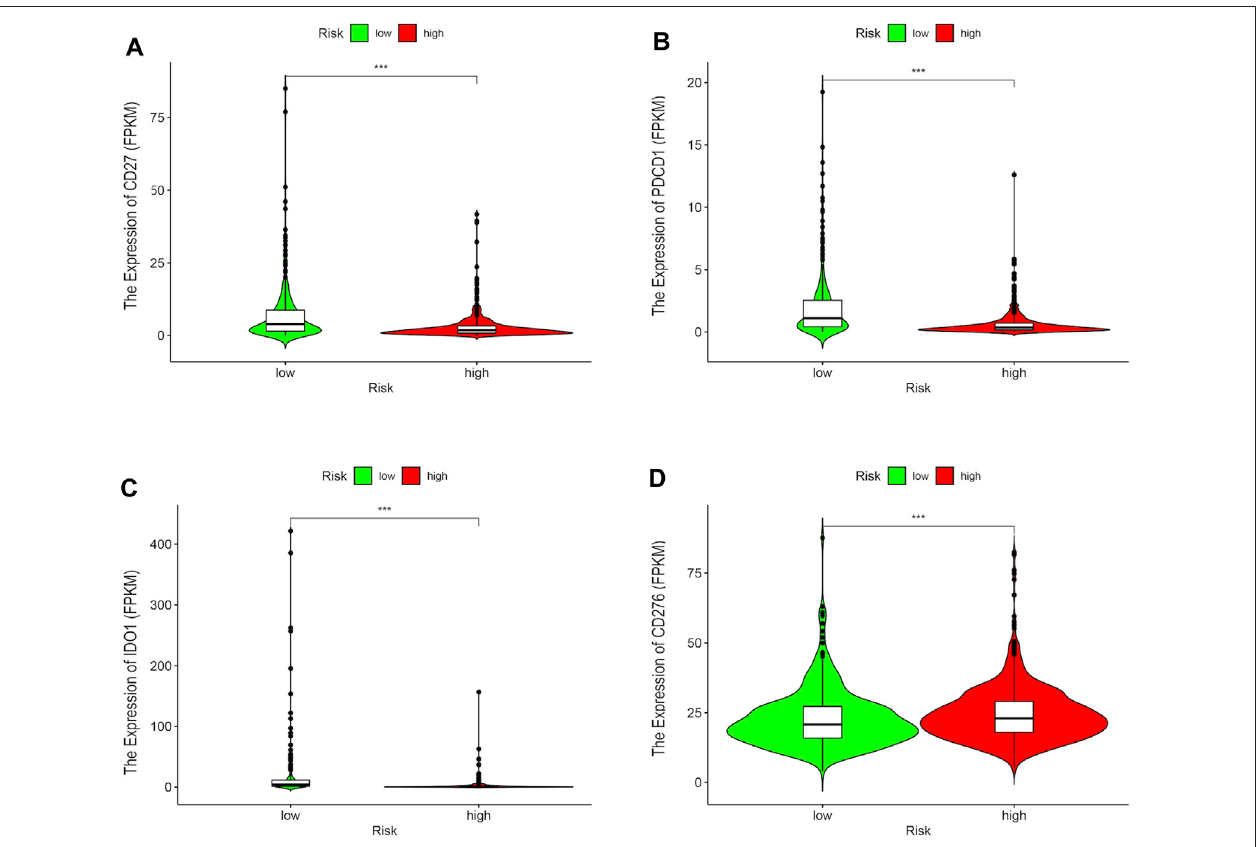
FIGURE 4 | The correlation between the risk signature and the expressions of several ICs. The high-risk group exhibited lower expressions of CD27 (A) , PCDC1 (B) , and IDO1 (C) , and higher expression of CD276 (D) than those in the low-risk group.